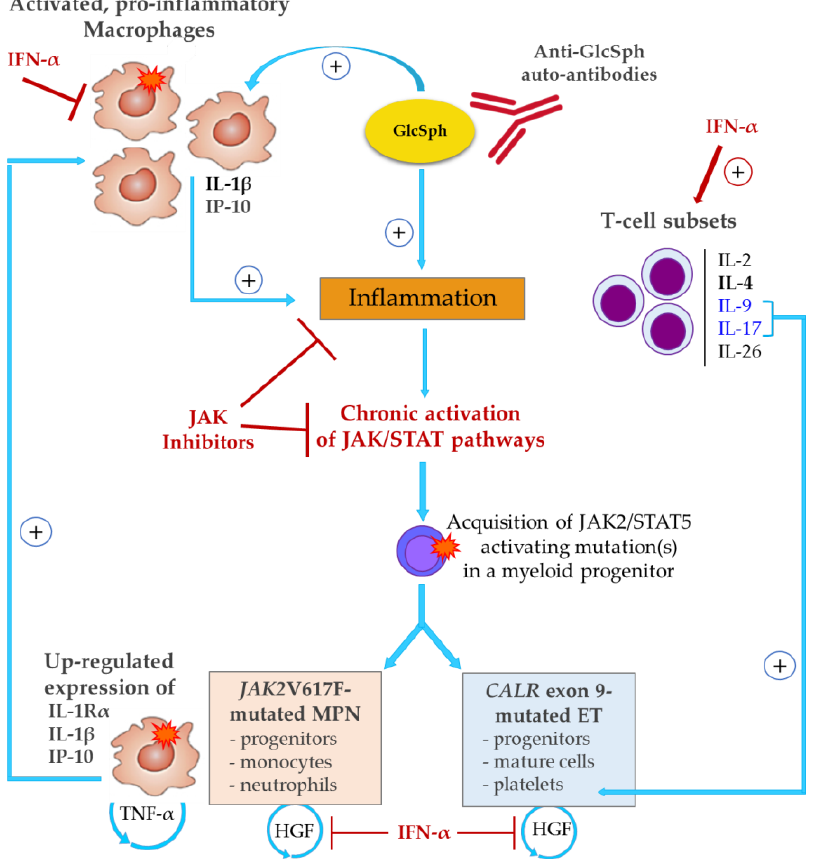
Figure 8. JAK2 V617F-dependent vs. mutation-independent inflammation in MPNs. At least 26 cytokines are overproduced in MPNs. CALR mutants did not alter cytokine production, whereas JAK V617F increased the expression of IL-1R α , IL-1 β and IP-10. Other cytokines overexpressed in MPNs are presumably produced by nonmutated cells, and this type of inflammation is likely to precede the acquisition of JAK2/STAT5 activating mutations. An autoimmune response to GlcSph, observed in 20% of MPNs, could be an early cause of chronic inflammation — and excessive IL-1 β production — eventually leading to the acquisition of JAK2 or CALR mutations and MPN development. In JAK2 V617F-mutated MPNs, strongly inflammatory IL-1 β associated with IL-1R α expression, both induced by JAK2 V617F, further stimulate cytokine production by both nonmutated cells of the bone marrow environment and mutated cells. JAK2 V617F-mutated cells also secrete TNF- α , known to enhance clonal expansion. Neither IL-1 β nor TNF- α signal via JAK/STAT, and thus are not sensitive to JAK inhibitors. In contrast, IFN- α represses IL-1 β , and also HGF, an autocrine survival factor for clonal MPN progenitors. In addition, IFN- α stimulates T-lymphocyte subsets that secrete anti-inflammatory IL-4, and two prothrombopoiesis and prothrombosis cytokines—IL-9 (an inducer of IL-4) and IL-17.